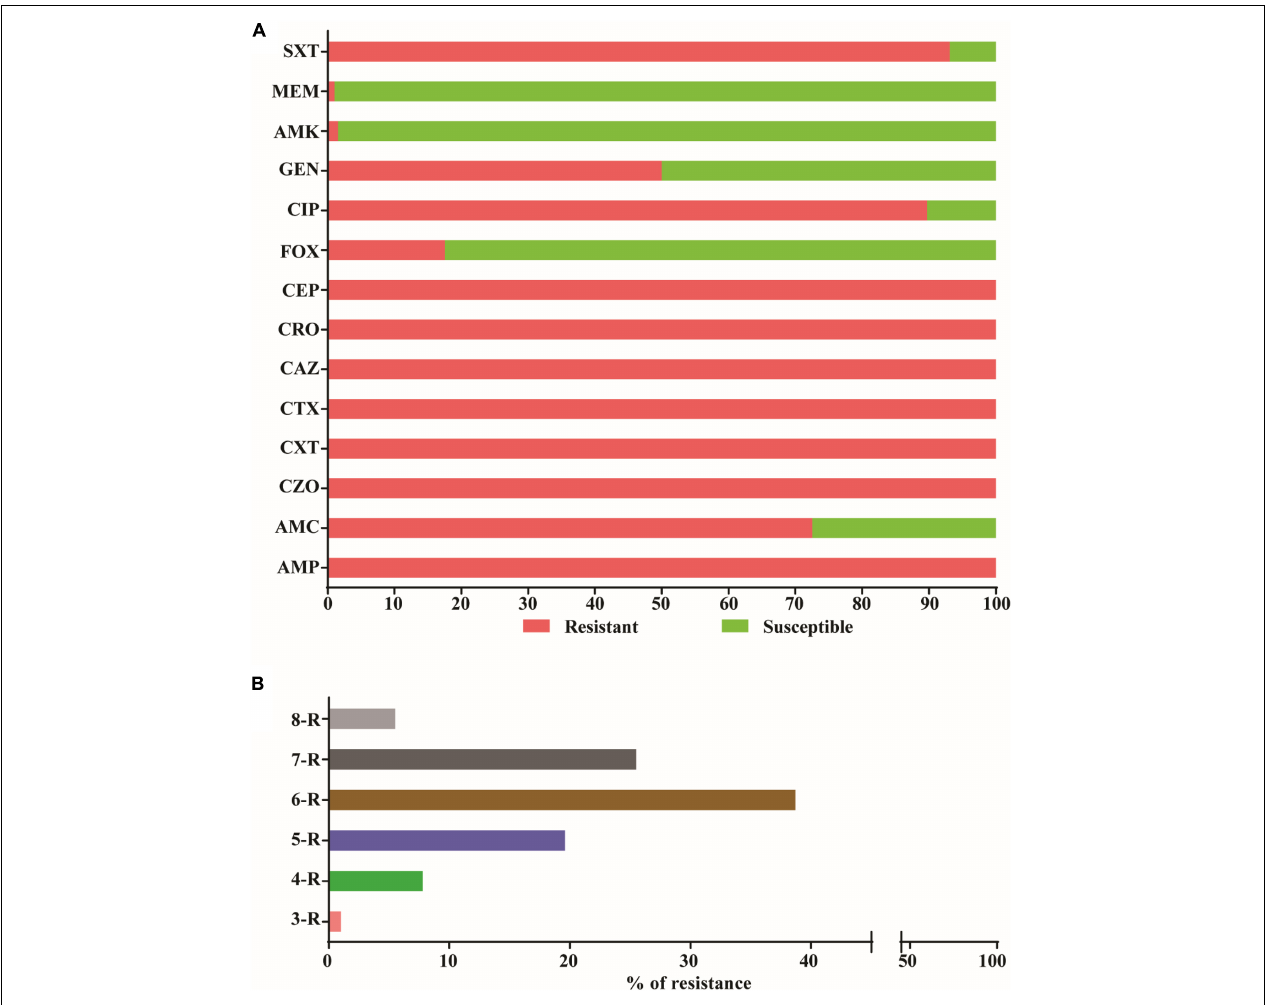
FIGURE 2 | Antibiotic susceptibility profile and multidrug resistance patterns. (A) The percent resistance of 204 ESBL positive E. coli isolates from four health facilities in Ethiopia according to the CLSI disk diffusion breakpoints. Resistance was defined as isolates with intermediate resistance and complete resistance inhibition zone size. Antibiotics tested were ampicillin (AMP), amoxicillin-clavulanate (AMC), cefazolin (CZO), cefuroxime (CXM), cefotaxime (CTX), ceftazidime (CAZ), Ceftriaxone (CRO), cefepime (CEF), cefoxitine (FOX), ciprofloxacin (CIP), Amikacin (AMK), gentamicin (GEN), Meropenem (MER), and Sulphamethoxazole-Trimethoprim (SXT). (B) The percent resistance to three or more categories of antibiotics among the 204 ESBL producing E. coli . The numbers 3–8 represent the number antimicrobial categories and R stands for